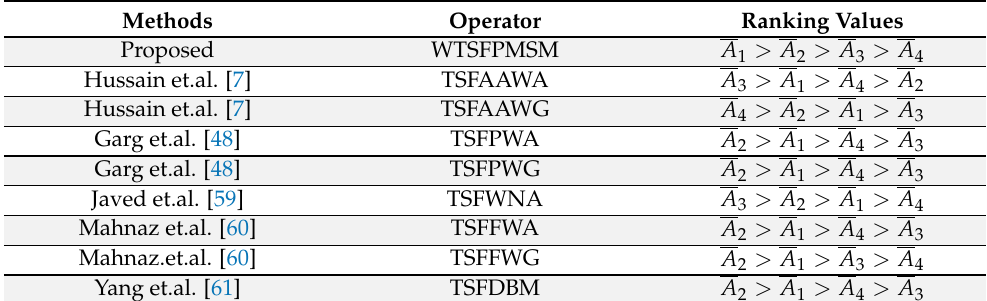
Table 20. Comparative analysis of the proposed and existing operators by using the information in Table 4.